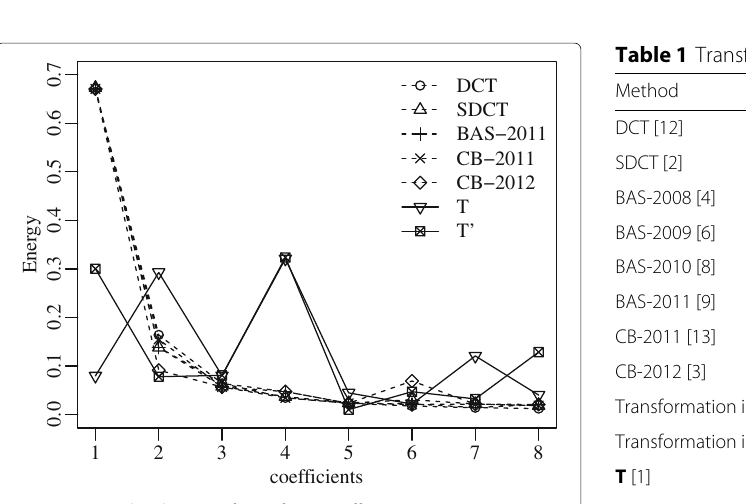
Fig. 2 Energy distribution of transform coefficients